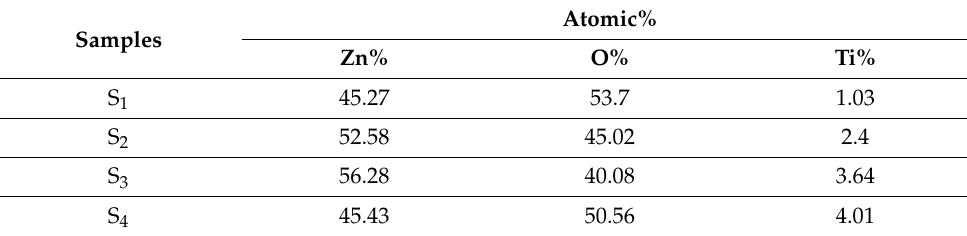
Table 1. EDX atomic percentages for the synthesis of nanocomposites on PTFE substrates (S 1 ) 1:7,